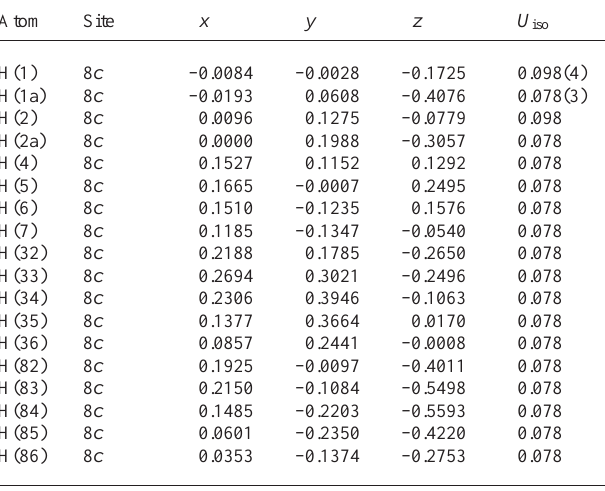
Table 2. Atomic coordinates and displacement parameters (in Å 2 )